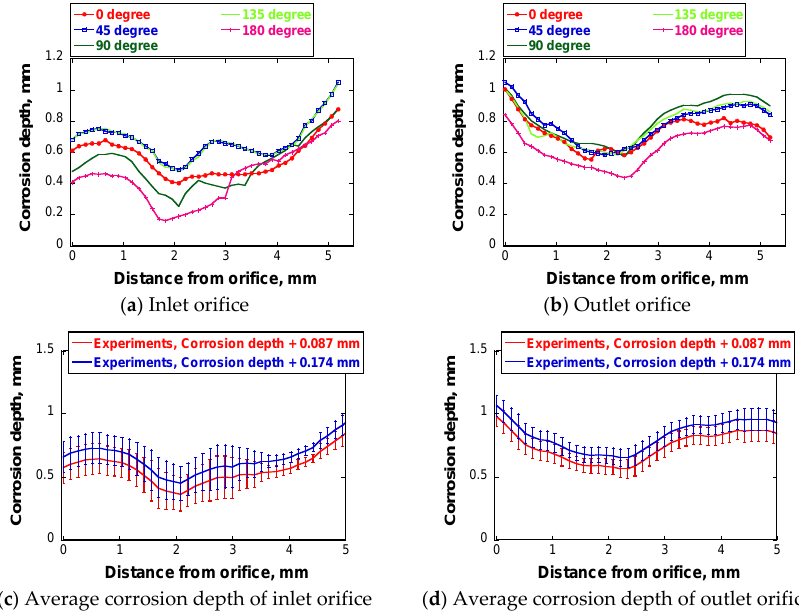
Figure 8. ( a , b ) Corrosion depth profiles of the inlet and outlet orifices at various circumferential angles as a function of the distance along the orifice surface. Fabrication deviations of 0.087 mm are added in the measured corrosion depth; ( c , d ) average corrosion depth of inlet orifice and outlet orifice. Fabrication deviations of 0.087 mm and 0.174 mm are added in the measured average corrosion depth,